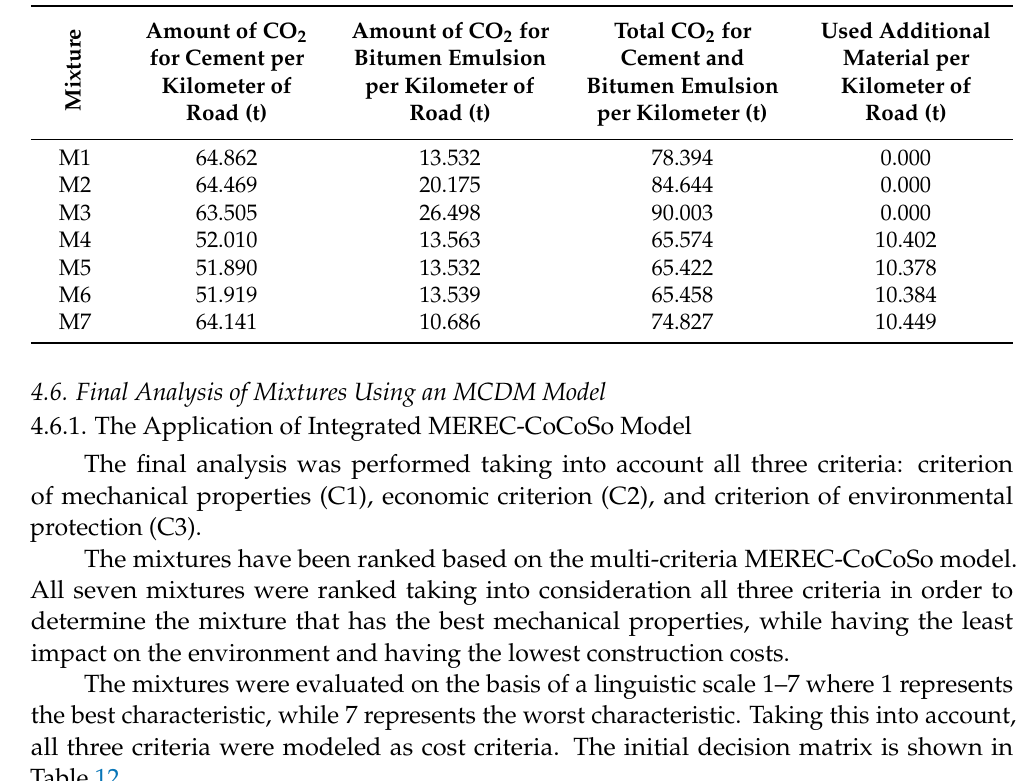
Table 11. Amounts of CO 2 emission of cement and bitumen emulsion for all